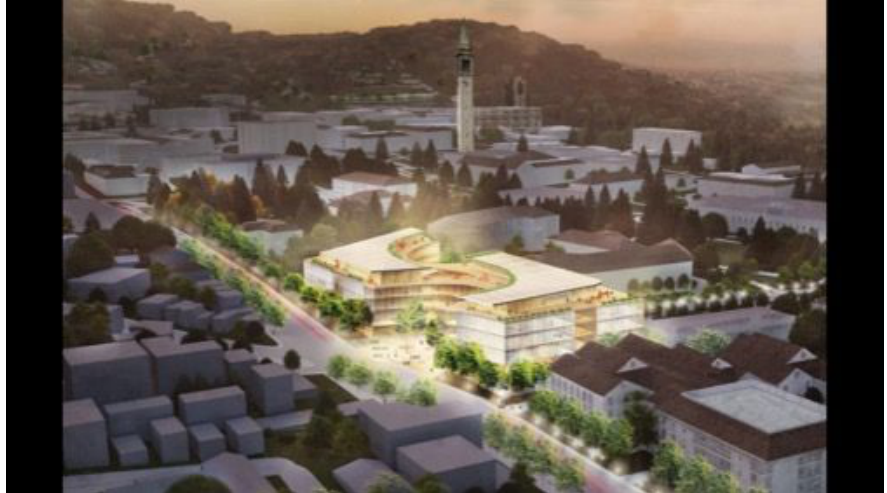
Figure 1. Aerial view of the planned new home of CDSS in the northwest part of the UC Berkeley campus. Images courtesy of Weiss/Manfredi and Gensler architectural firms. Note: Design is provisional and in development.